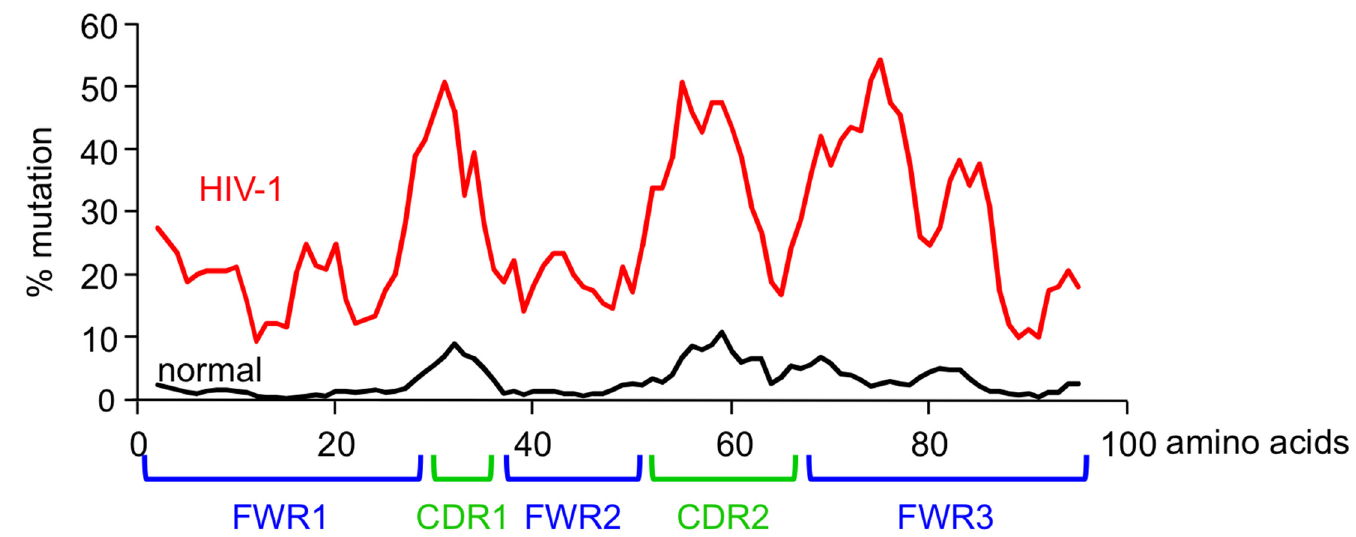
Fig 2. Frequency of nucleotide mutations across the heavy chain variable gene segment in normal (black) and HIV-1 (red) antibodies. The x -axis shows amino acid numbering of FWR and CDR areas. Data adapted from Rosner et al. [22] and Scheid et al. [21].